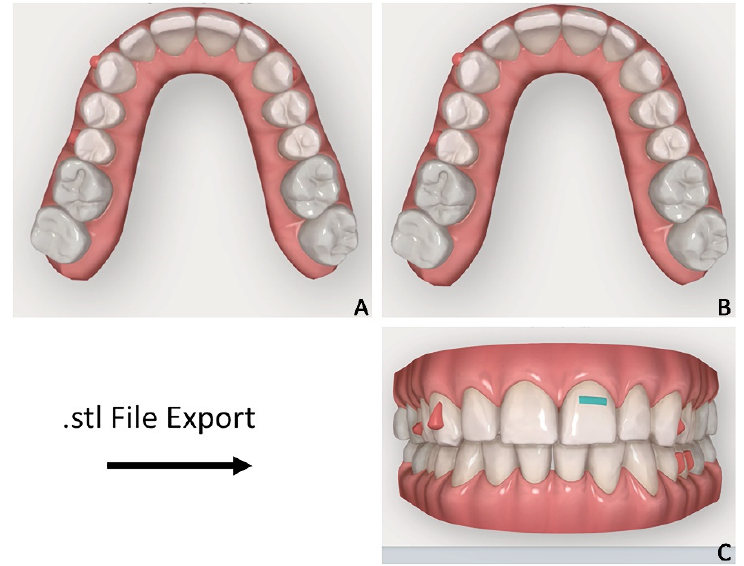
Figure 3. Case 1. Orthodontic set-up for staging movement for clear aligners therapy (Invisalign Go). ( A ) Pre-staged occlusal view; ( B ) post-staged occlusal view; ( C ) post-staged frontal view. 3.